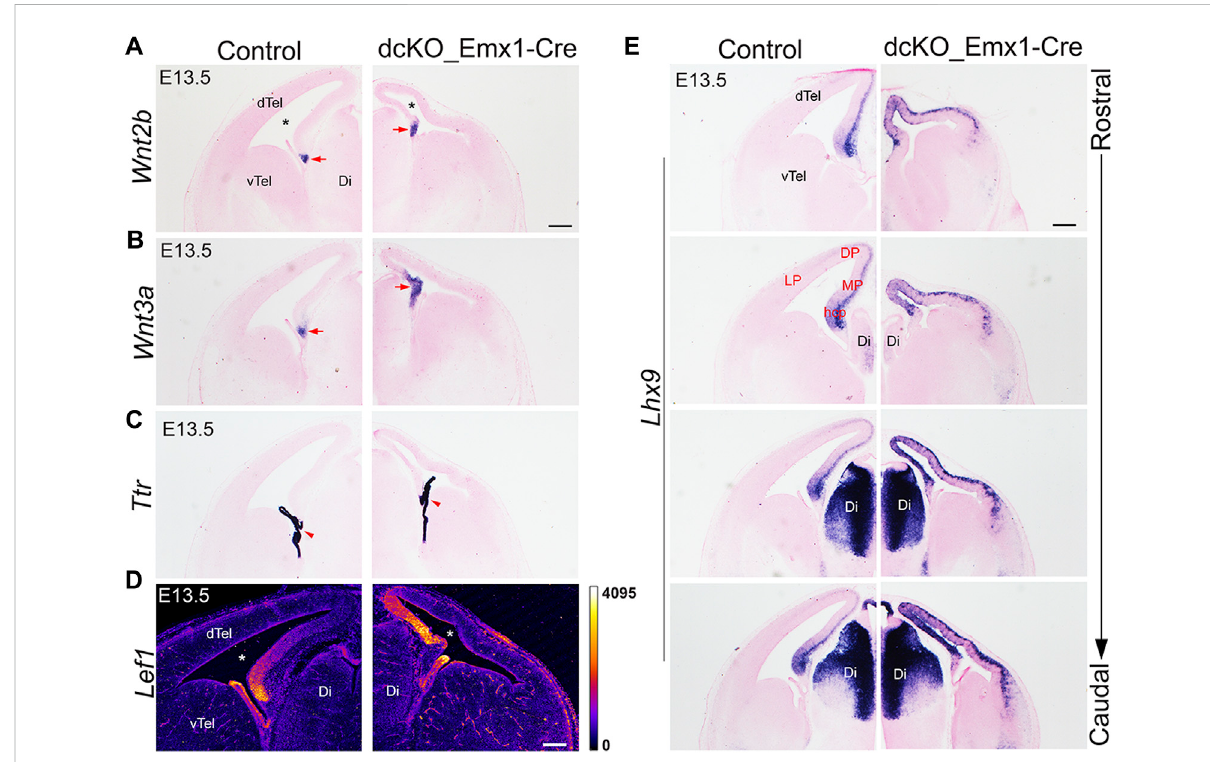
FIGURE 3 Early loss of BAF complex in the developing dorsal telencephalon distorts cortical patterning. (A – E) Images showing in situ hybridization or immuostaining in the control and dcKO_Emx1-Cre E13.5 mouse (dorsal) telencephalon with the riboprobes Wnt2b (A) and Wnt3a (B) to mark the cortical hem, Ttr (transthyretin) to mark the choroid plexus (C) , LEF1 antibody to stain the medial cortex (D) , and Lhx9 for revealing the cortical hem andmedialcortexinrostraltocaudalsections (E) .Thelateralventricleisindicatedbyanasterisk.Arrowpointstocorticalhem.Arrowheadpoints to choroid plexus Abbreviations: dTel, dorsal telencephalon; vTel, ventral telencephalon Ch, cortical hem; Di, Diencephalon. LP, lateral cortex; DP, dorsal cortex; MP, medial cortex; hcp, hippocampal primordium. Scale bar: 200